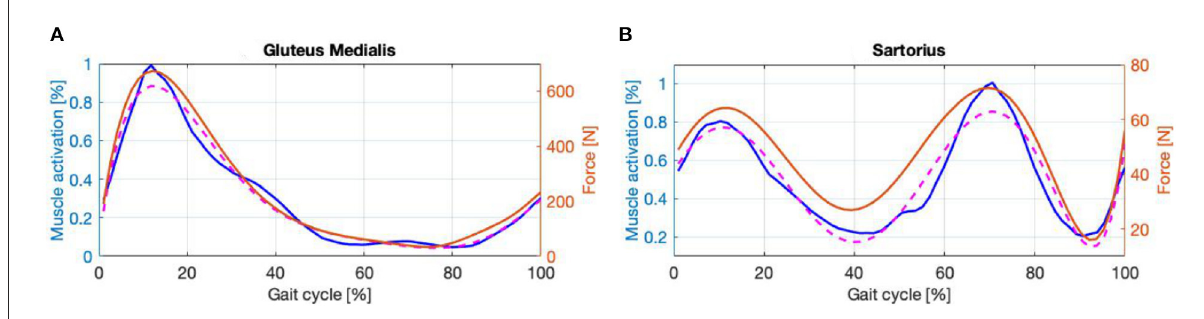
FIGURE6 (A,B) Envelope (blue line), interpolatin curve (dashed line) and force signal (magenta